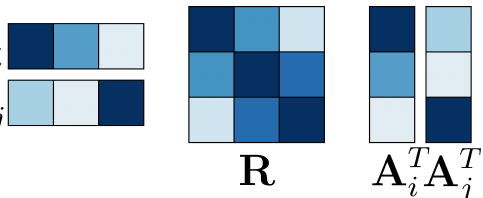
Figure 3. The affinity matrix R describes the relationships between the latent factors. Illustrated here are two word embeddings, corresponding to the words w i and w j . Darker shades represent larger values. In this example we predict a large co-occurrence at S ii and S jj because of the large weight on the diagonal of the R matrix. We predict a low co-occurrence at S ij and S ji since the large weights on A i 1 and A j 3 interact with low weights on R 13 and R 31